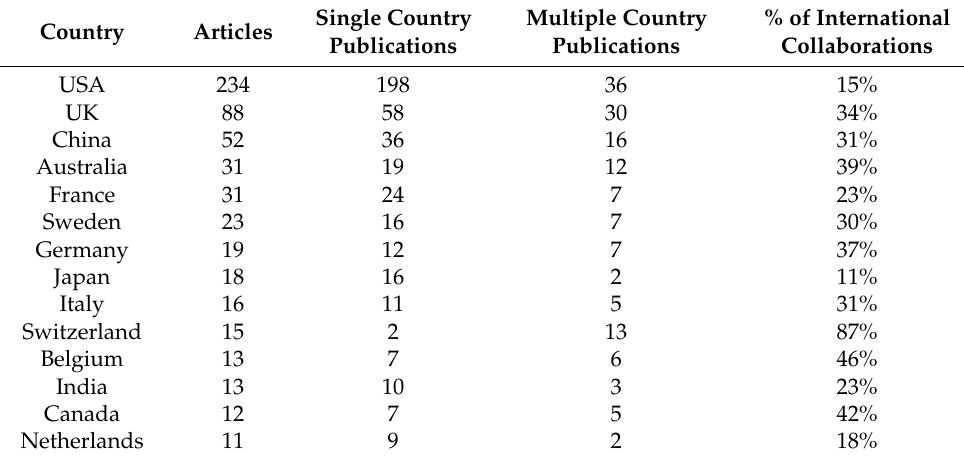
Table 2. Country-specific scientific production for articles focused on autism spectrum disorders.